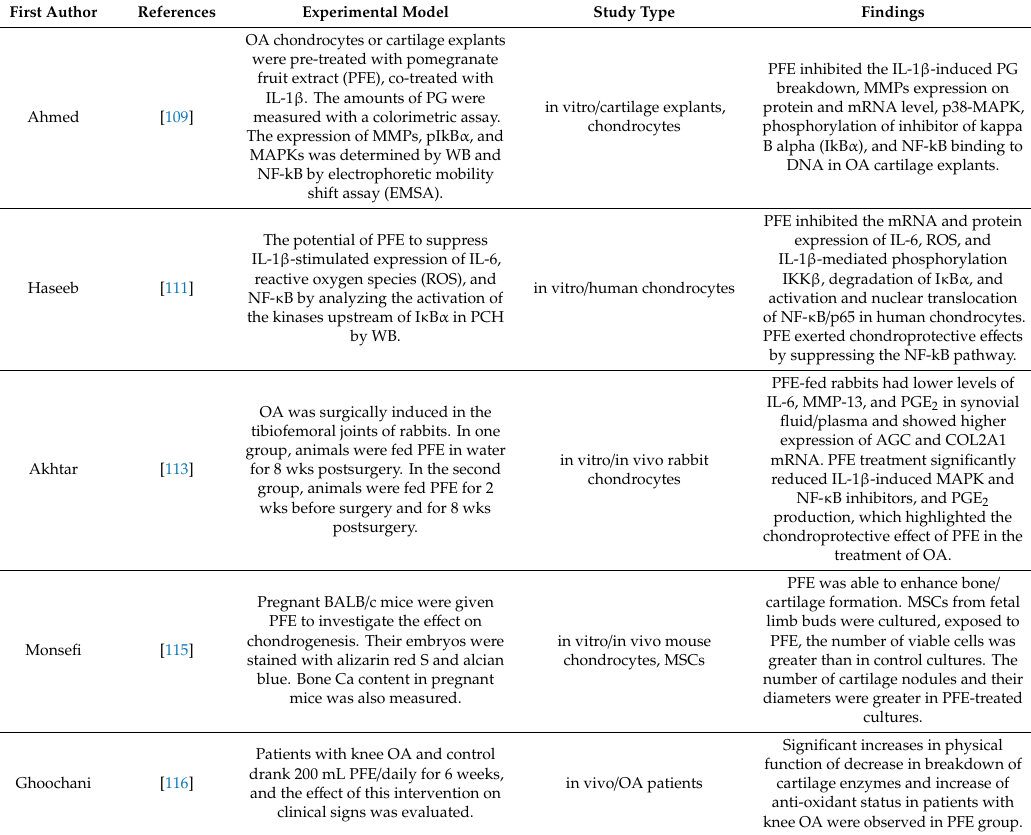
Table 5. Pomegranate application in cartilage tissue